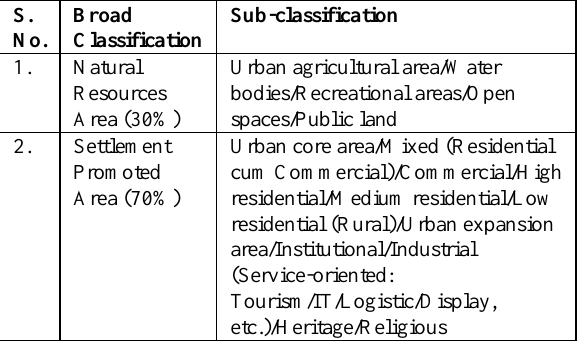
Table 3. Types of land use for Metro City. © Planning Norms and Standards, 2015